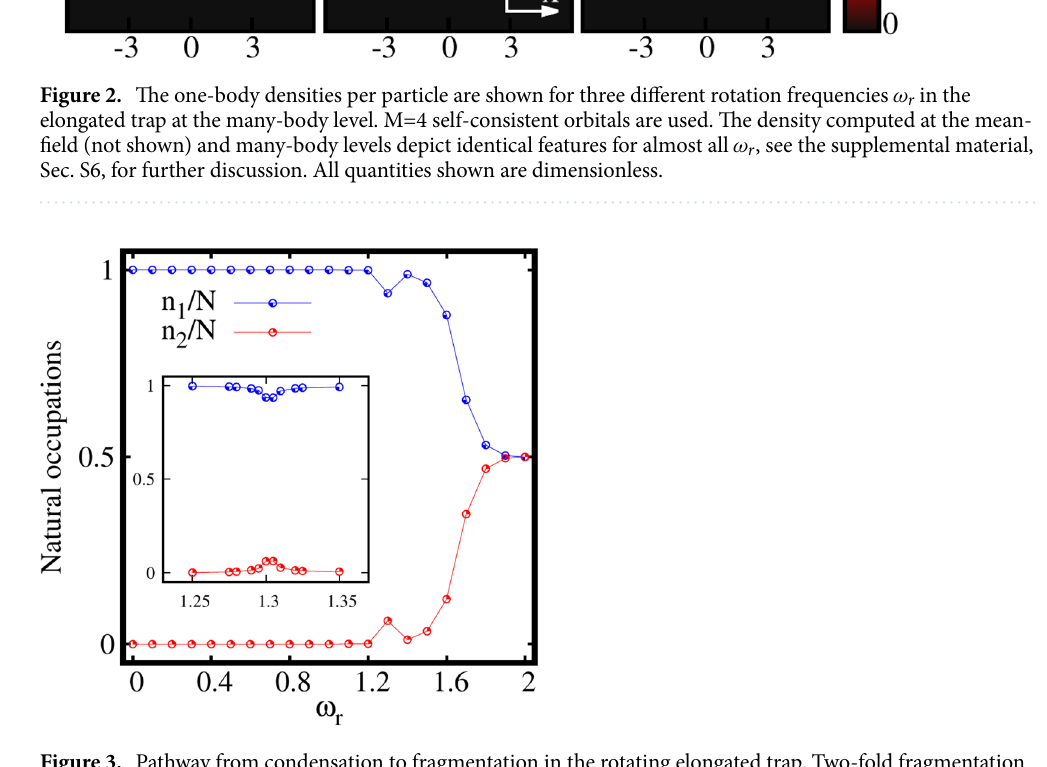
Figure 3. Pathway from condensation to fragmentation in the rotating elongated trap. Two-fold fragmentation is observed with increase in rotation. The two leading natural occupations n 1 / N and n 2 / N , are shown as a function of the rotation frequency ω r . M = 4 self-consistent orbitals are used. The third and fourth natural occupations satisfy n 3 / N , n 4 / N ≤ 10 − 5 , see the supplemental material. All quantities shown are